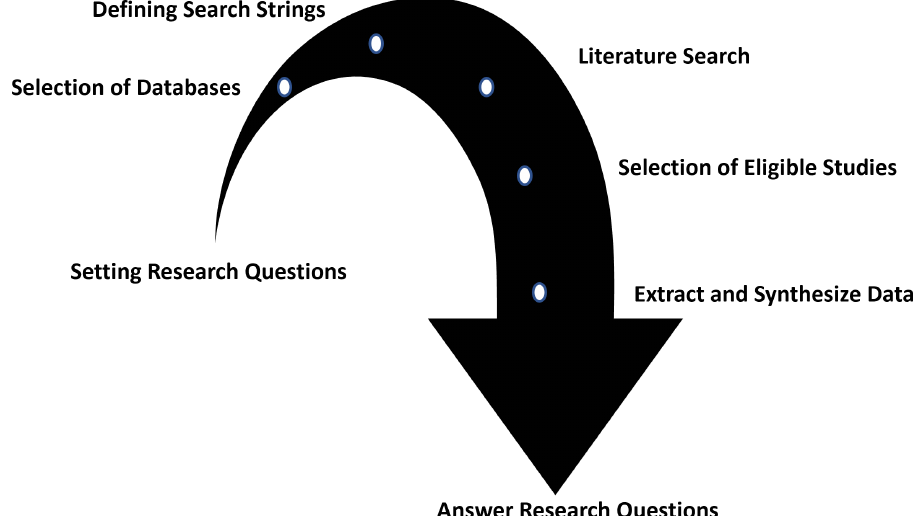
Figure 2. Planning and reporting process of systematic literature review